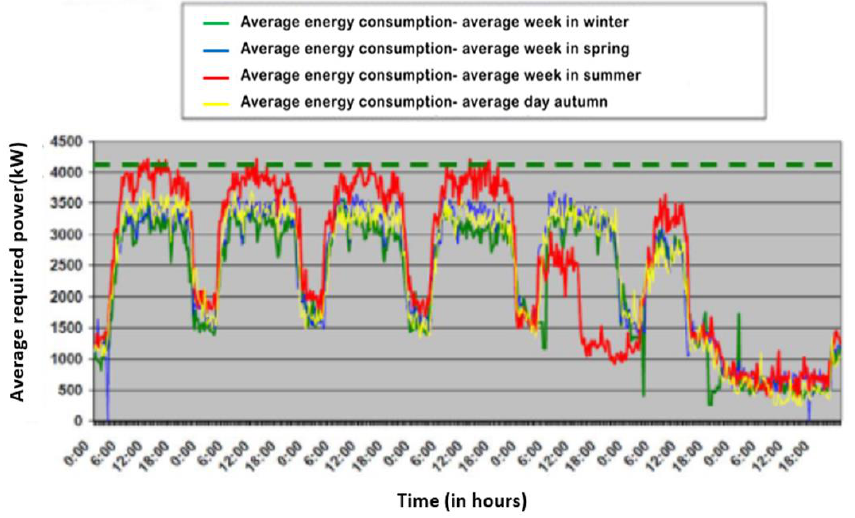
Figure 1. Electricity consumption profile during average week in the factory.